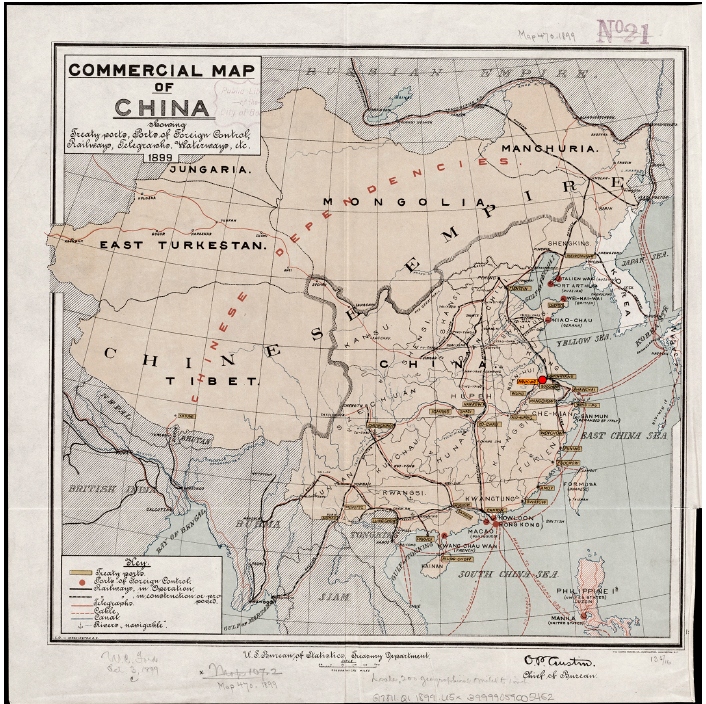
Figure 3. The location of Nanjing in the east–west cultural exchanges in 1889. Modified from [32].